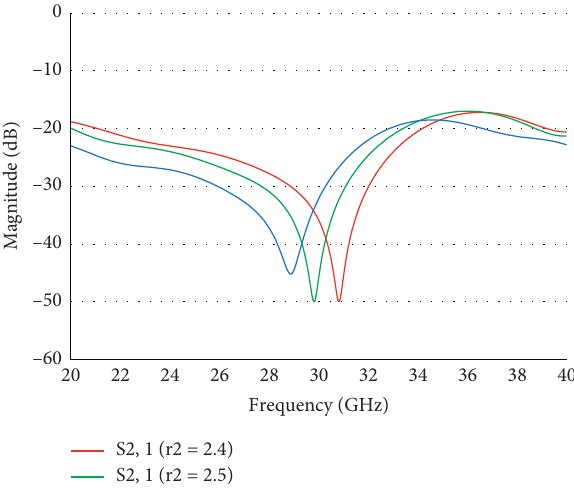
Figure 3: Effect of “ R